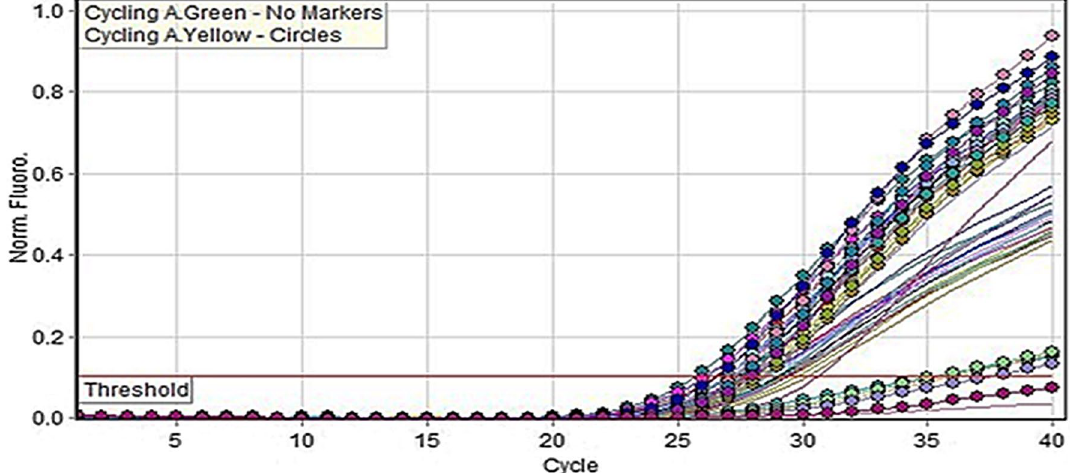
Fig. 2 VIC/FAM dye fluorescence on cycle